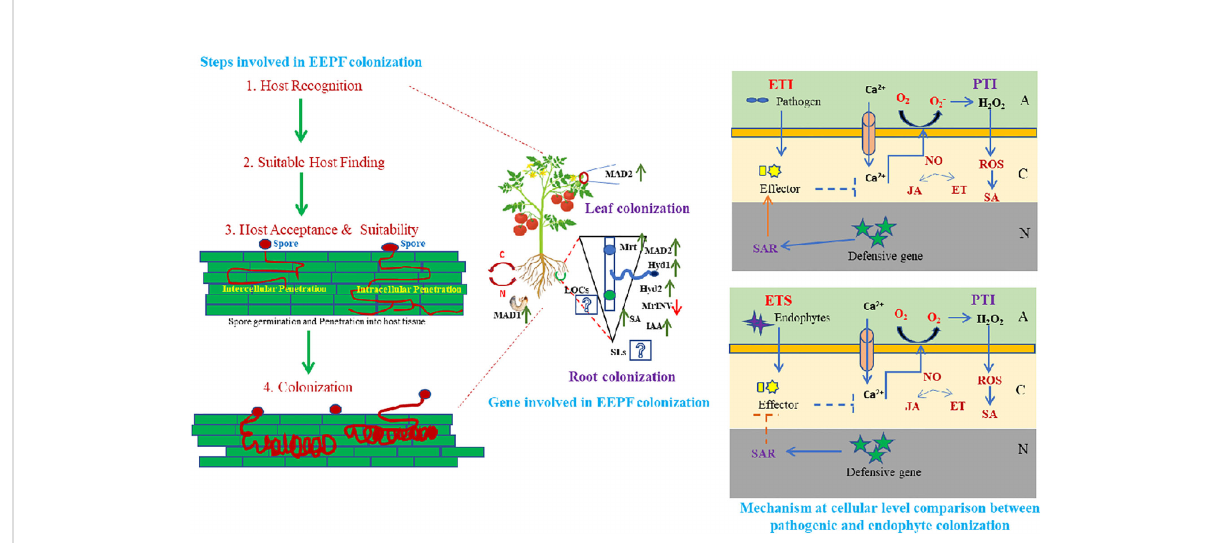
FIGURE 1 Host identi fi cation and establishment by entomopathogenic fungal endophytes involves diverse steps i.e. host recognition, suitable host fi nding, host acceptance and suitability followed by spore germination and penetration into host tissue leading to fungal colonization. This